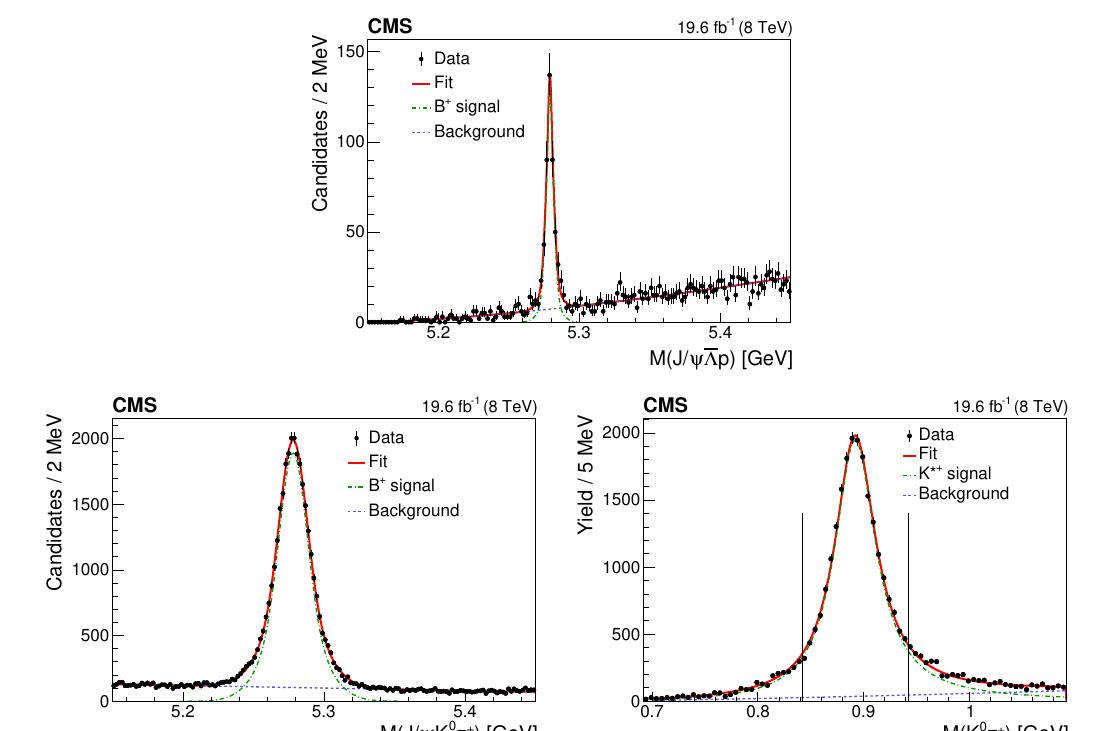
Figure 1 . The invariant mass distribution of the selected B + ! J = (cid:3)p candidates (upper). The (cid:25) + (lower left) and K 0 (cid:25) + (lower right) for the B + ! J = K (cid:3) + invariant mass distributions of J = K 0 S S decay candidates. The points are data and the solid curves are the results of the (cid:12)ts explained in the text. The vertical bars represent the statistical uncertainty. On the lower right picture the (cid:25) + ) as a discriminating variable are shown. background-subtracted candidates using the M (J = K 0 S The dash-dotted curves show the B + signal in the upper and lower left plots, and the K (cid:3) + signal in the lower right plot. The dashed lines indicate the background contributions. The vertical lines in the lower right plot indicate the K (cid:3) + invariant mass window used for the normalization, as described in the